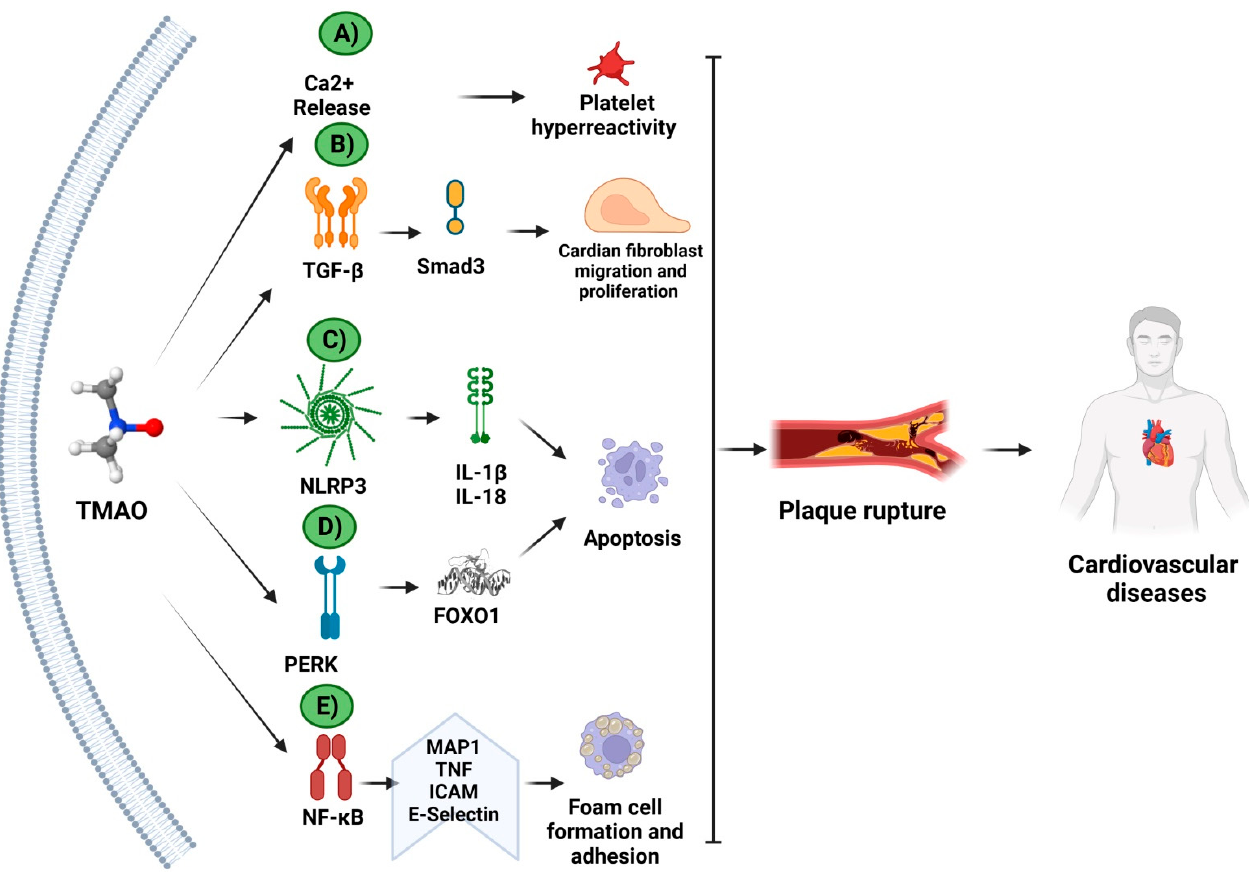
Figure 3. Molecular mechanisms of TMAO in cardiovascular diseases. The mechanism of TMAO in cardiovascular diseases has been studied in animal and/or cellular models. TMAO increases the ( A ) Ca 2+ release and platelet hyperactivity; ( B ) TFG- β activation and Smad3 signaling pathway; ( C ) NLRP3 inflammasome activation, inducing apoptosis; ( D ) PERK-unfolding protein response (UPR) activation and endoplasmic reticulum stress; and ( E ) NF- κ B translocation and foam cell formation and adhesion. Together, these mechanisms contribute to plaque ruptures, and, therefore, to heart disease. (Created with